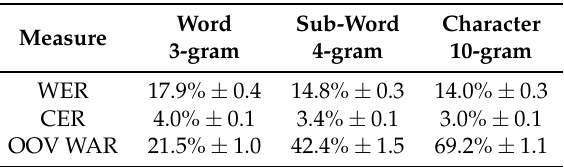
Figure 19. Results obtained by the CRNN character-based system using n -gram language models with size n = { 1, . . . ,15 } . Table 5. Overall best results on the Rodrigo test set in terms of WER, CER and OOV WAR for the CRNN